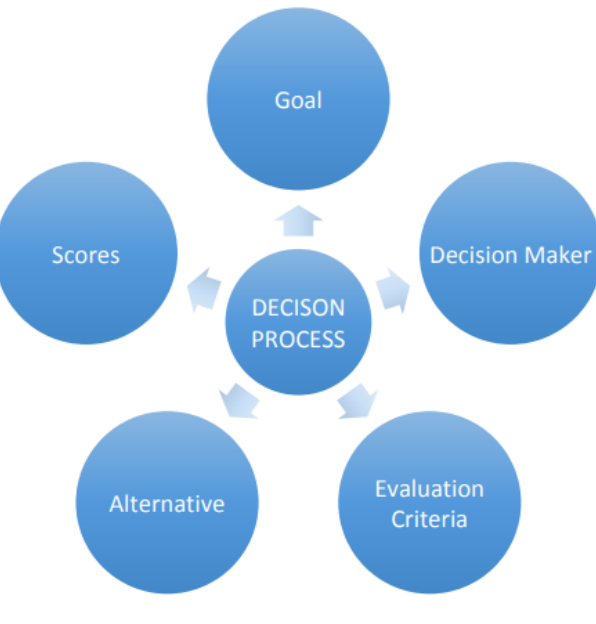
Figure 1. Elements of a decision-making